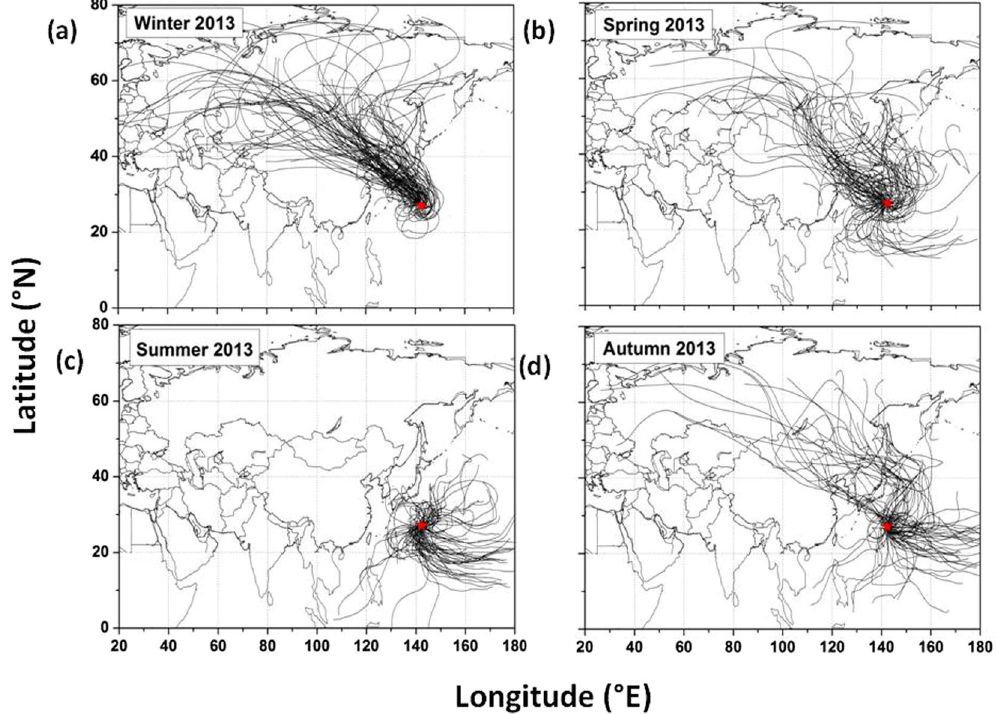
Figure 1. Daily 7-day HYSPLIT backward air mass trajectories for different seasons over the WNP for the year 2013. The star ( * ) indicates the sampling site, Chichijima Island. Trajectory data downloaded from the NOAA ARL website (http://www.arl.noaa.gov) and plotted using origin lab (v.8) software